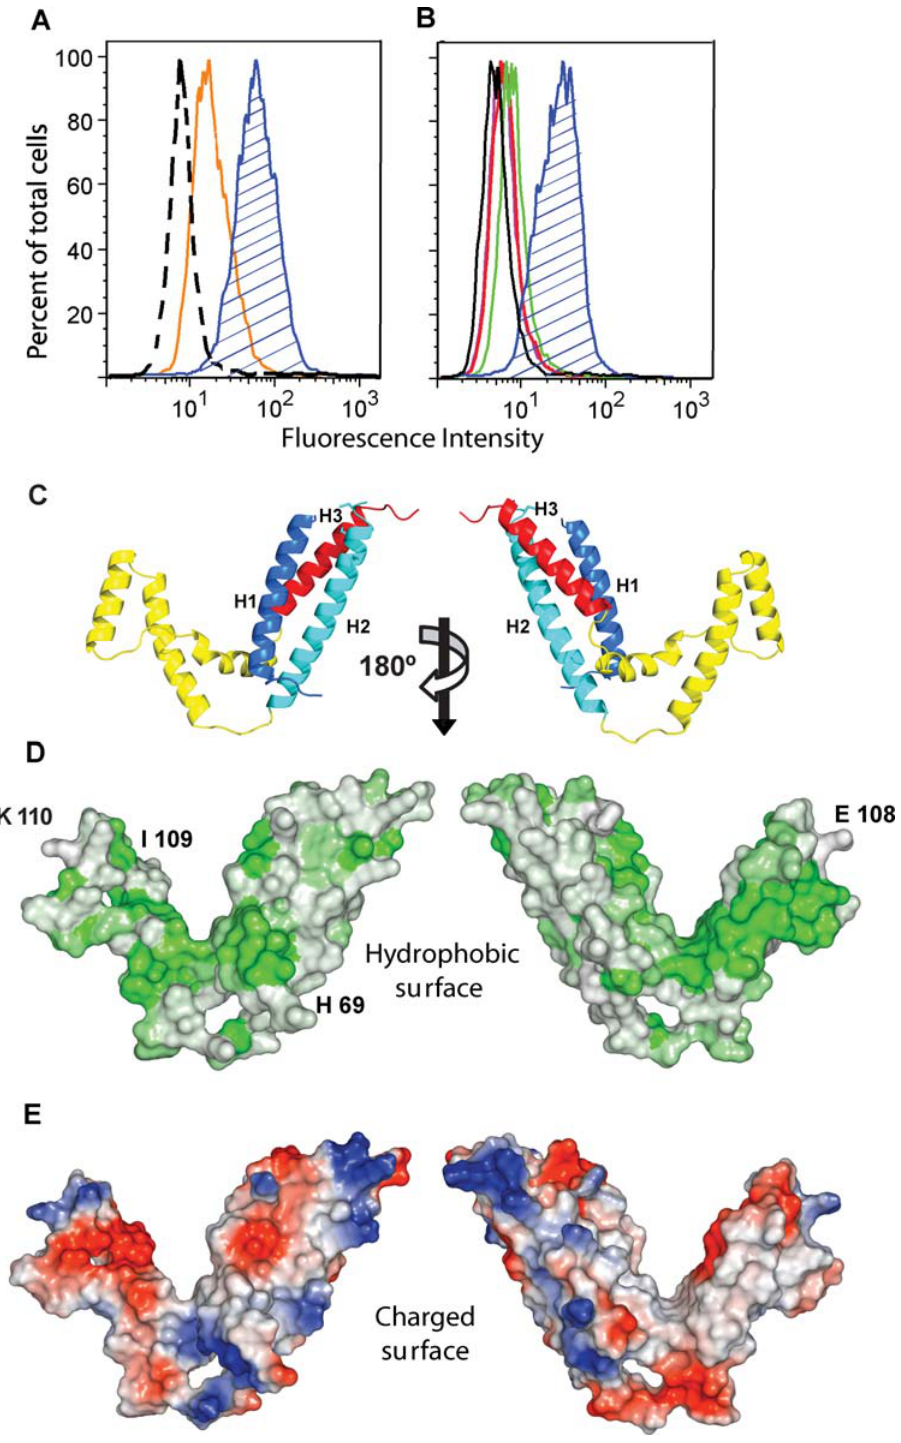
Figure 2. MC179 binding to CD36. Refolded MC179 bound to CD36-transfected CHO cells as assayed by flow cytometry ([A,B]; blue hatched peaks). (A) Incubation of MC179 with CD36-Fc fusion protein (100 m g/ml) diminished MC179 binding to CD36 on cells (orange peak). MC179 binding was revealed with anti-MC179 Aotus immune serum. (B) MC179 binding to CD36 is inhibited by each of three anti-CD36 mAbs (peaks outlined in red, violet, and green). The violet peak is under the red peak and is only partially visible. Binding of MC179 was visualized with an anti-pentaHis mAb. In both panels, controls used untransfected cells (peaks outlined in black). In (A), Aotus preimmune serum yielded results (not shown) identical to the untransfected control. (C) Ribbon diagrams of MC179 in the same orientations as (D) and (E). Three-helix bundles are located towards the center of the figure and connecting helices are at the sides. (D) Two views of the hydrophobic surface 180 u apart show a hydrophobic patch (green, at right) on the connecting helices of MC179. Labeled residues are those reported to affect CD36-binding (see text). (E) Surface views of MC179 showing the distribution of positive (blue) and negative (red) surface charge. The negatively charged region (red, at left) on the connecting helices is on the opposite face from the hydrophobic patch at the right in (D).